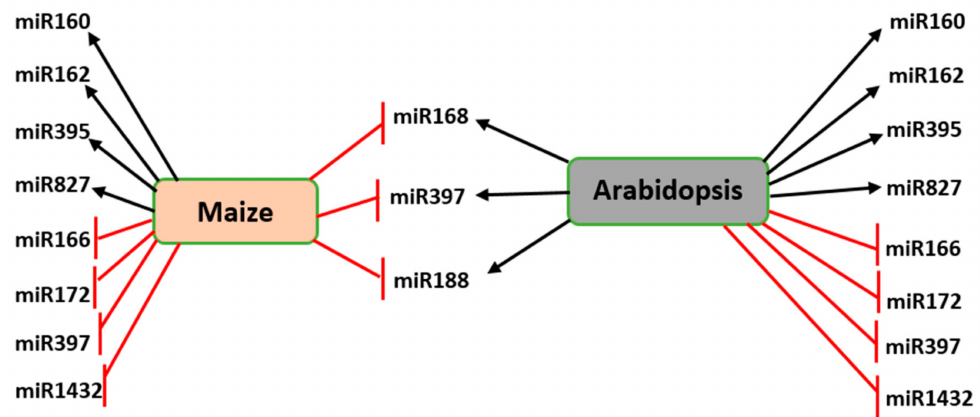
Figure 6. Di ff erential expression of commonly expressed miRNAs in maize and Arabidopsis during the drought stress response. Expression of miR168, miR397, and miR188 is down-regulated in maize but up-regulated in Arabidopsis . A red blunt arrow indicates a decrease while the black arrow represents an increase in the expression of the corresponding miRNA.